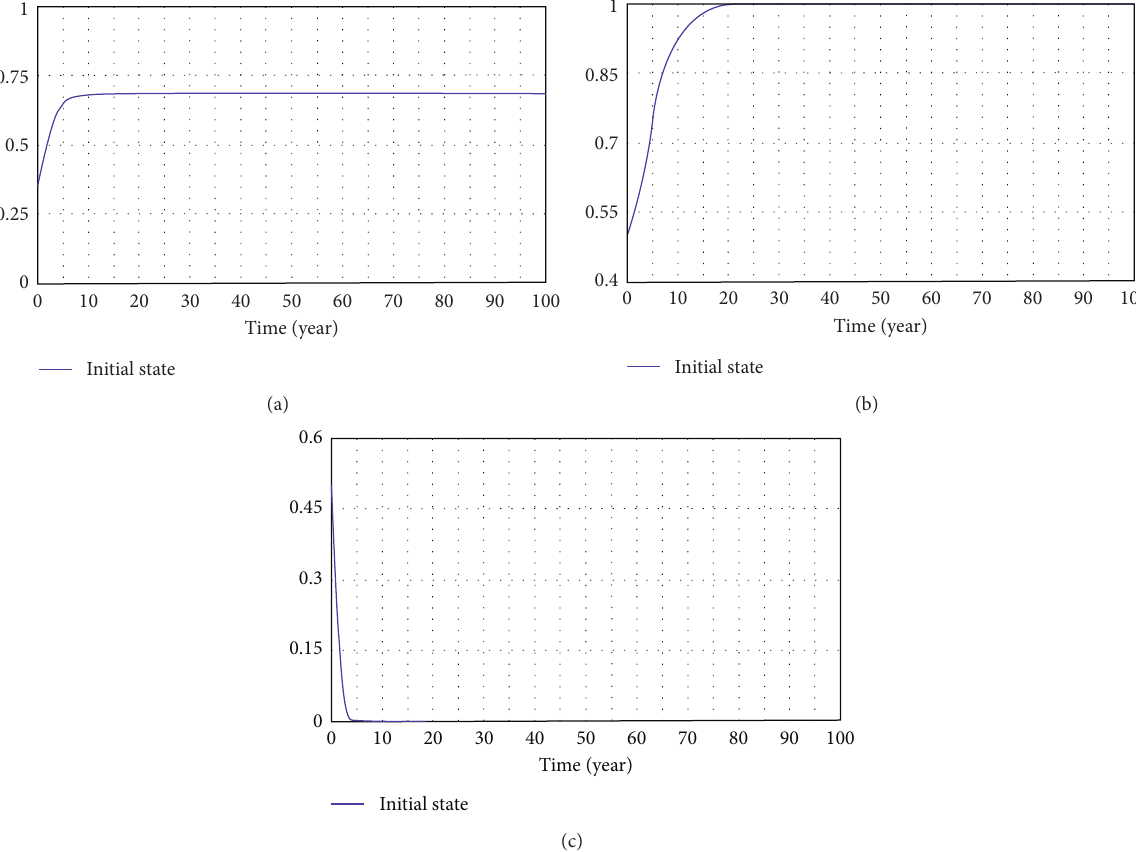
Figure 2: Simulation results of the proposed game. (a) Probability of the enterprise upgrading facilities. (b) Probability of the government’s regular inspection. (c) Probability of the residents appealing to